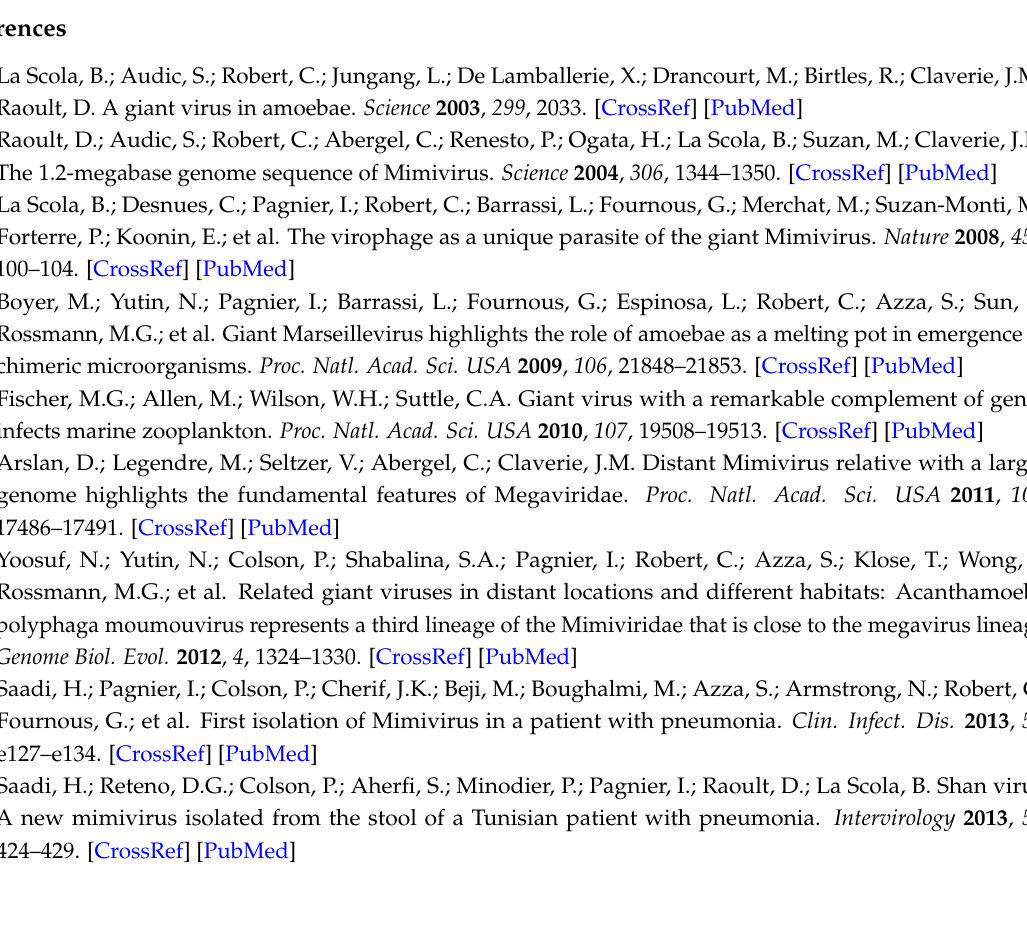
Figure S1. No large-scale repeated regions were observed in the Kaumoebavirus genome. A: Pairwise sequence alignment of the Kaumoebavirus against itself (dot plot). B: Pairwise sequence alignment of the concatenated peptide sequences of Kaumoebavirus proteins. Figure S2. Concatenated proteins pairwise sequence alignment (dot plot) of Kaumoebavirus against itself and the fully sequenced Faustovirus E9, Faustovirus Liban and African swine fever virus strain E75. The Kaumoebavirus retains no observed collinearity with the other viruses. Figure S3. Phylogenetic reconstruction performed for Kaumoebavirus and other Megavirales members. Phylogenetic reconstruction was performed using the maximum likelihood method and was based on A32-like packaging ATPase. Figure S4. Phylogenetic reconstruction performed for Kaumoebavirus and other Megavirales members. Phylogenetic reconstruction was performed using the maximum likelihood method and based on D5-like helicase. Figure S5. Phylogenetic reconstruction performed for Kaumoebavirus and other Megavirales members. Phylogenetic reconstruction was performed using the maximum likelihood method and based on DNA topoisomerase. Figure S6. Phylogenetic reconstruction performed for Kaumoebavirus and other Megavirales members. Phylogenetic reconstruction was performed using the maximum likelihood method and based on the transcription termination factor. Figure S7. Comparative genomics of Kaumoebavirus and representatives of Faustoviruses and Asfarviridae family